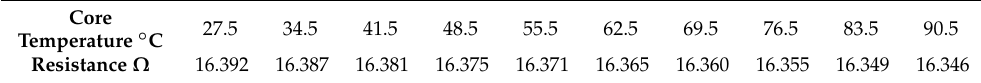
Table 3. Resistance of the heating unit at different temperature.